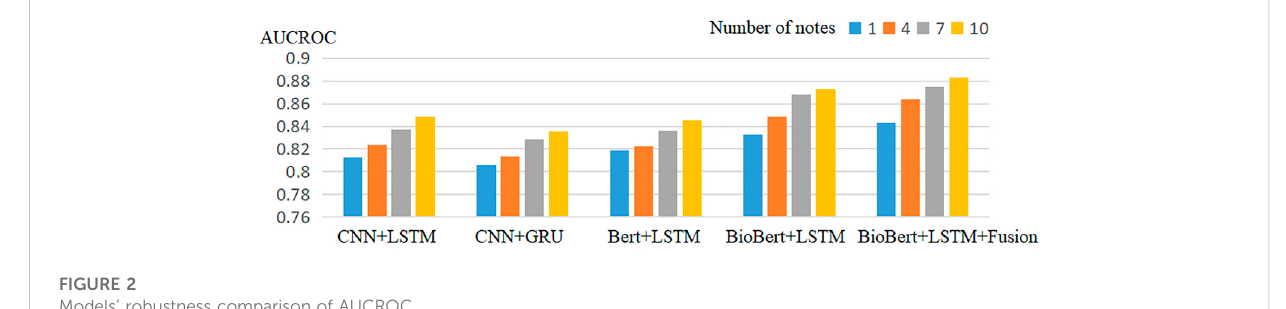
FIGURE 2 Models ’ robustness comparison of